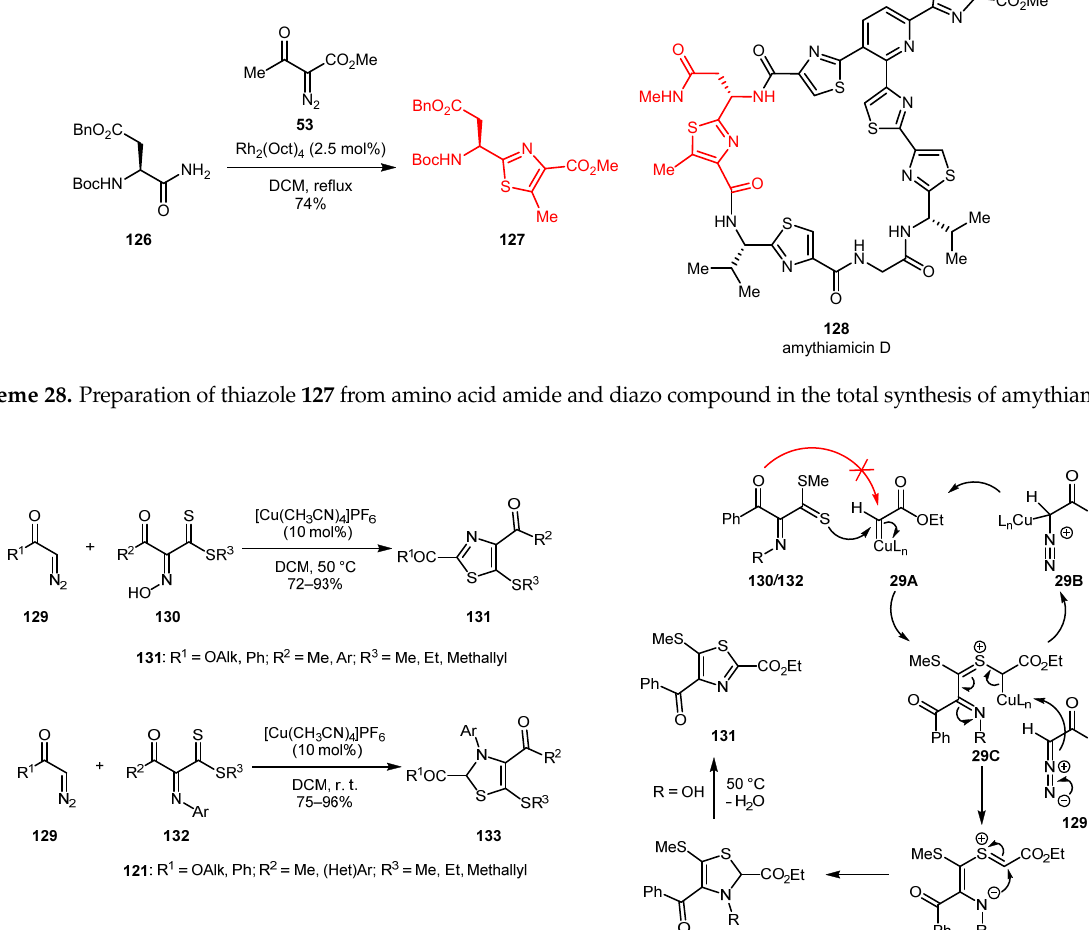
Scheme 28. Preparation of thiazole 127 from amino acid amide and diazo compound in the total synthesis of amythiamicin